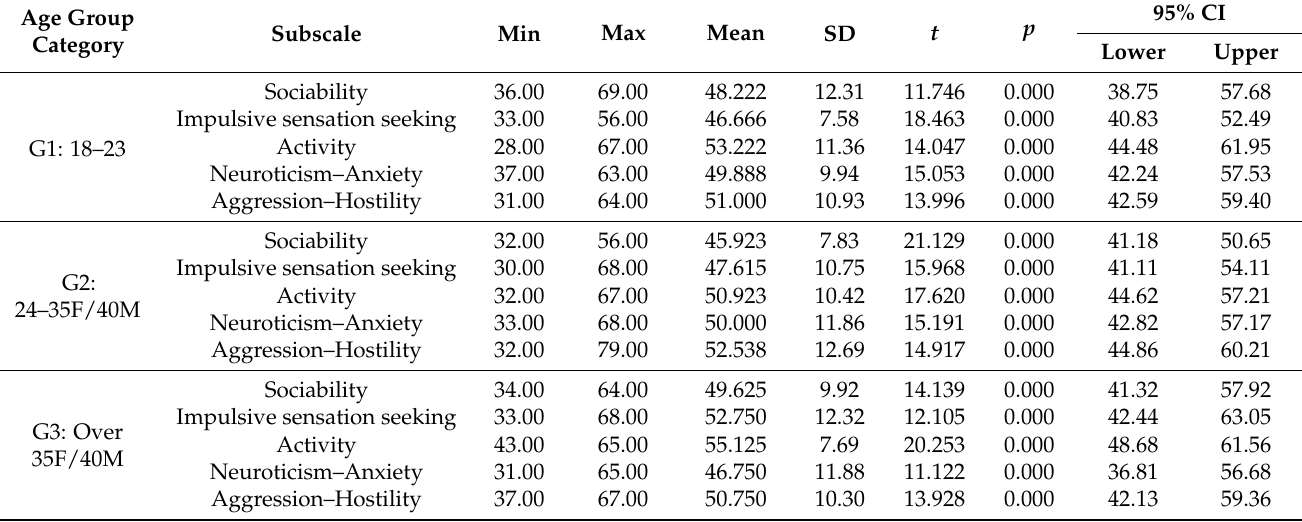
Table 5. Descriptive statistics of the results for the Zuckerman–Kuhlman Personality Questionnaire (ZKPQ)